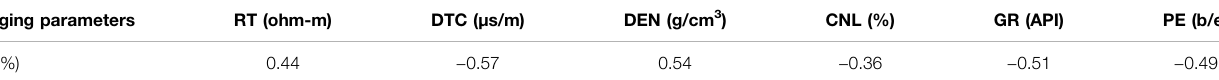
TABLE 2 | Correlation coef fi cient between brittleness index and logging parameters. Logging parameters